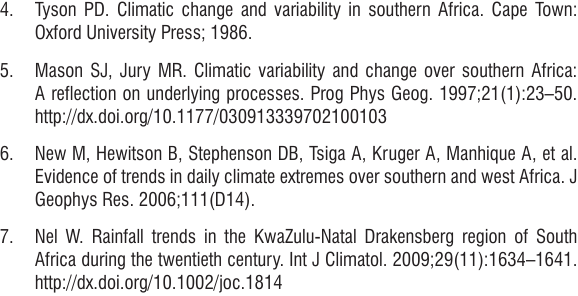
Figure 9: Correspondence between observed trends and downscaled global climate model trends for 1960–2010. Trends are averages for stations in each of the six water management regions (abscissa) for summer (DJF), autumn (MAM), winter (JJA), spring (SON) and annual (Ann) means. Asterisks show observed trend and box-and-whisker plots represent the 11 downscaled model trends. Black circles indicate models lying outside 1.5 times the interquartile